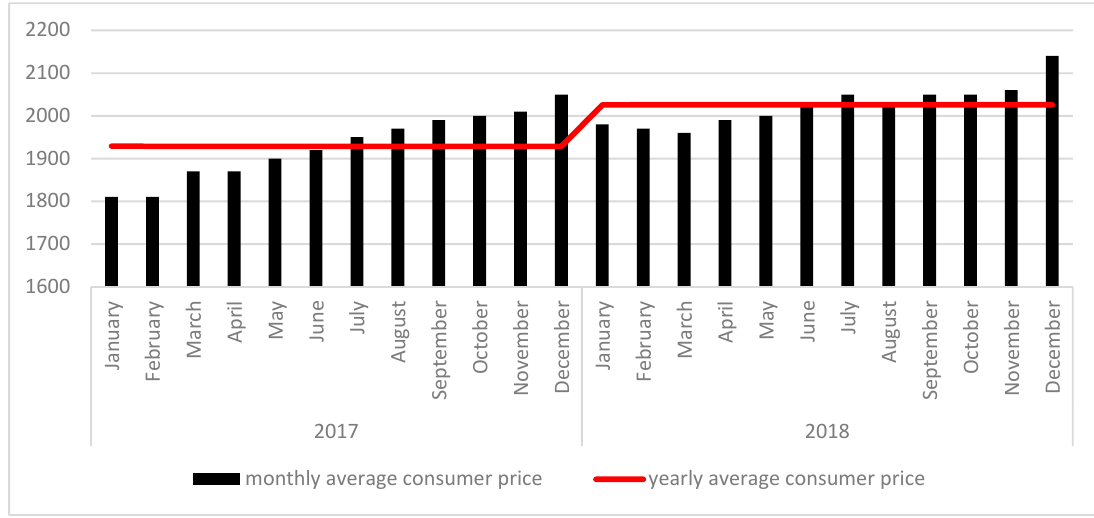
Figure 1. Monthly and yearly national average consumer price of a carp slice or fillet HUF/kg Source: [24].